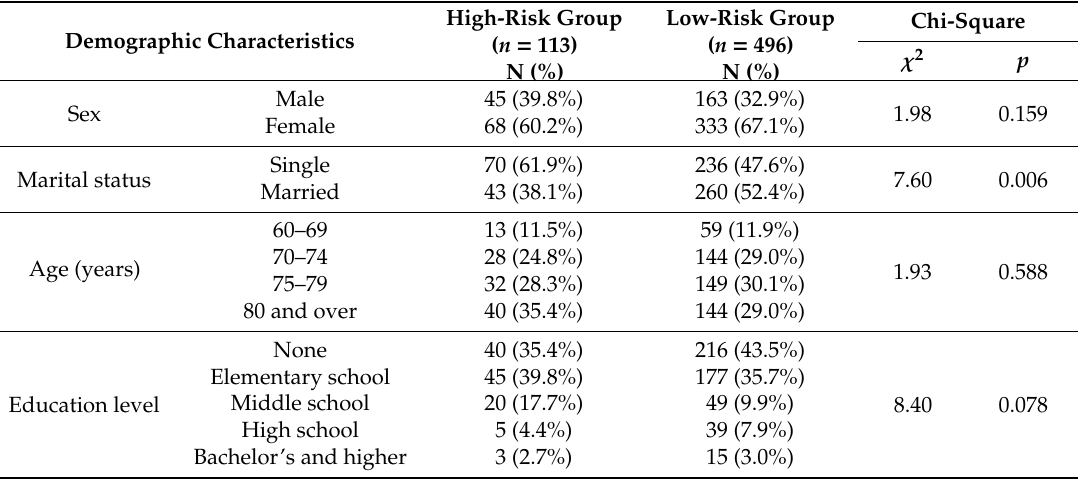
Table 2. Demographic characteristics.